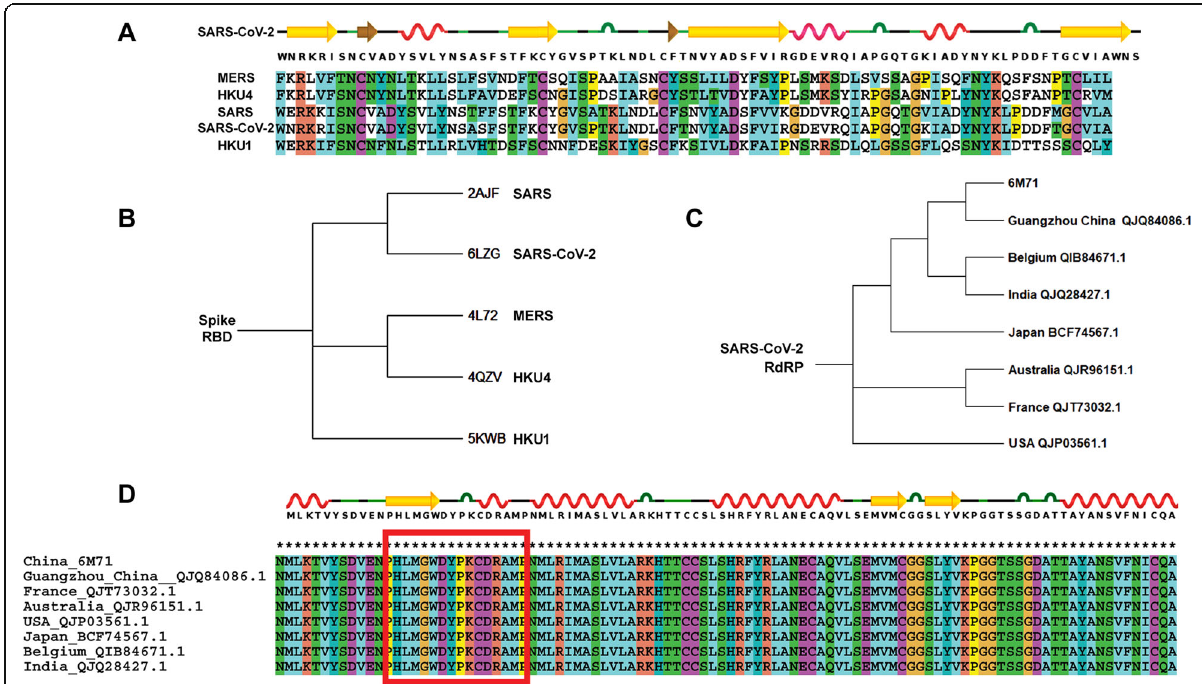
Fig. 1 Comparison of SARS-CoV-2 with closely related coronaviruses. A Amino acid sequence alignment for RBD of spike glycoprotein from SARS- CoV-2 and its closely related coronaviruses. B Phylogenetic analysis of related coronaviruses based on spike receptor-binding domain (RBD). C Phylogenetic analysis of RNA-dependent RNA polymerase (RdRP) of SARS-CoV-2 from different countries. D Amino acid sequence alignment for RdRP from SARS-CoV-2 and its contemporary strains present globally